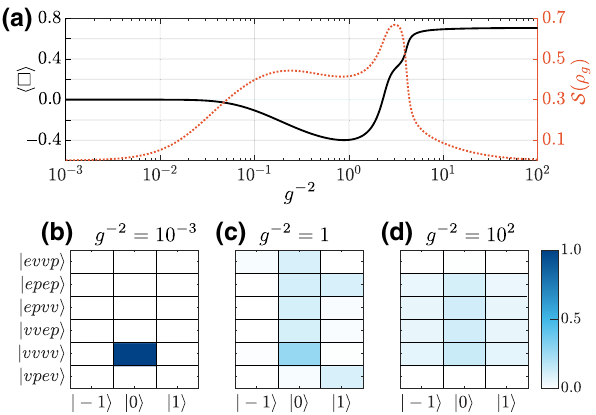
FIG. 9. The ground-state properties in the nonperturbative regime. (a) The plaquette operator expectation value (cid:8) (cid:2) (cid:3) and entanglement entropy S (ρ g ) as a function of g − 2 . (b)–(d) The probability by component of the ground state for the indicated g − 2 . At g − 2 = 10 − 3 , the lowest-energy state is the vacuum | vvvv (cid:3)| 0 (cid:3) . For g − 2 = 1, the ground state approximates that of the kinetic term. For large g − 2 , the magnetic Hamiltonian in the pres- ence of the kinetic Hamiltonian yields the tensor product between a superposition of matter states and the gauge ground state of the magnetic term. Through (a)–(d), we use (cid:4) = 5 and m = 0.1 and a gauge-field truncation l =